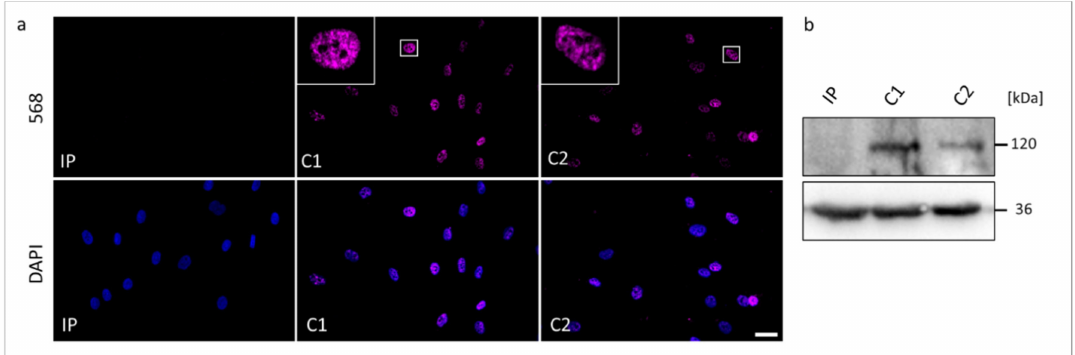
Figure 4. The RBM10 protein analyses in skin fibroblasts from the TARP-affected patient (IP) and unrelated control cell lines (C1 and C2). ( a ) Immunocytochemical detection of the RBM10 was performed with antibodies against RBM10 (magenta). Nuclear DNA was stained by DAPI (blue). The scale bar corresponds to 30 µ m. ( b ) Western blotting showed the expected molecular weight of RBM10 of 120 kDa in the protein samples from C1 and C2, while RBM10 was not detectable in the protein sample from IP. GAPDH (36 kDa) served as a loading